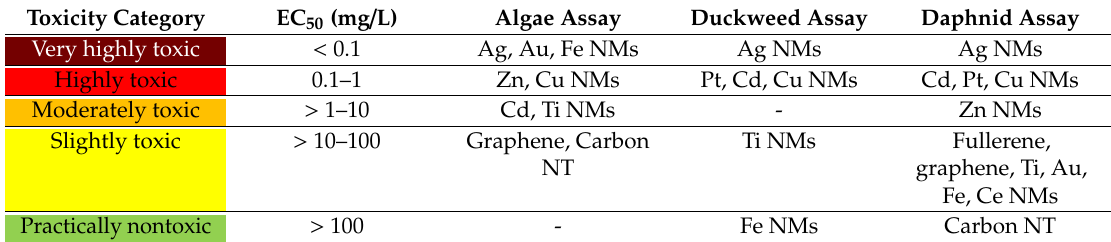
Table 7. Classification of NMs into the five aquatic toxicity categories based on their EC 50 values. Toxicity Category